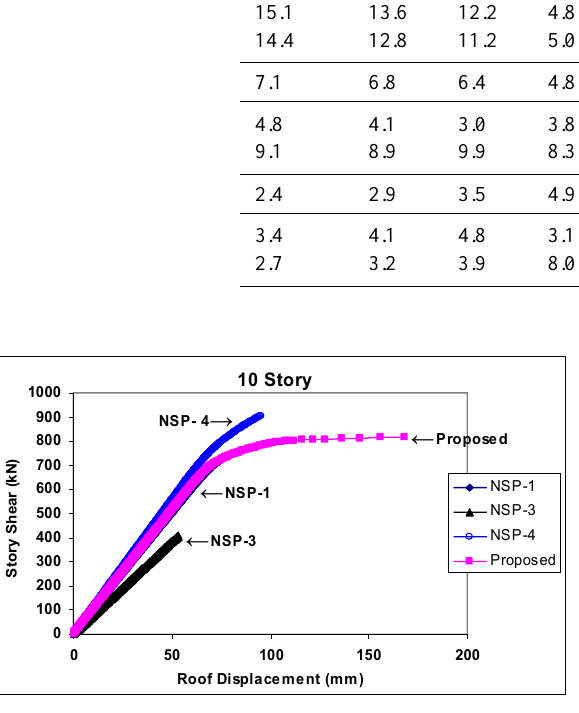
Figure 16. Base shear vs. roof drift response using different lateral load profiles for 10-storey building Fig. 15. Base shear vs roof drift response using different lateral load profiles for 10-storey